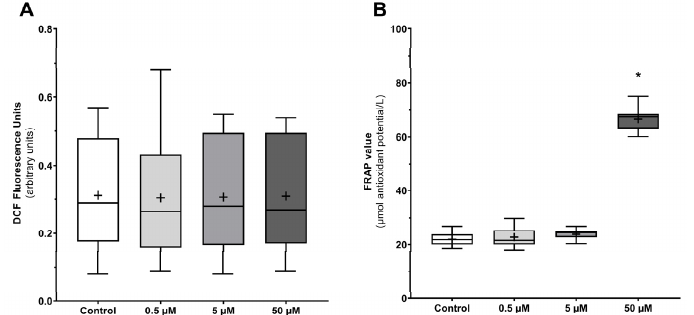
Figure 7. Culture media total antioxidant capacity and endogenous ROS production by human spermatozoa after UCPs inhibition by increasing concentrations of genipin (0.5, 5, and 50 µM) for 3 h. ( A ) Evaluation of endogenous ROS production using the CM-H 2 DCFDA dye. ( B ) Analysis of the culture media antioxidant potential through ferric antioxidant power (FRAP) assay. Results are expressed as Tukey’s boxplot (median, 25th to 75th percentiles ± 1.5 IQR). + − Represents group average. Significantly different results are expressed as: * − Relative to the control group.